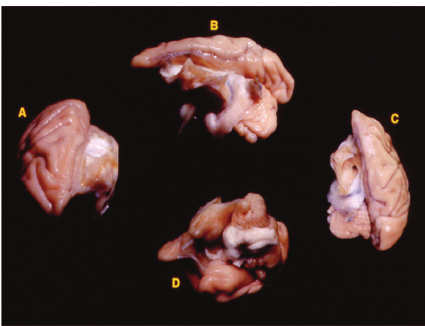
Figure 1: The complete removal of the left hemisphere was performed during infancy. Here, we show the results of the near complete removal of the left hemisphere four years after the initial surgery in the axial plane (A and C), lateral view (B), and orbital view